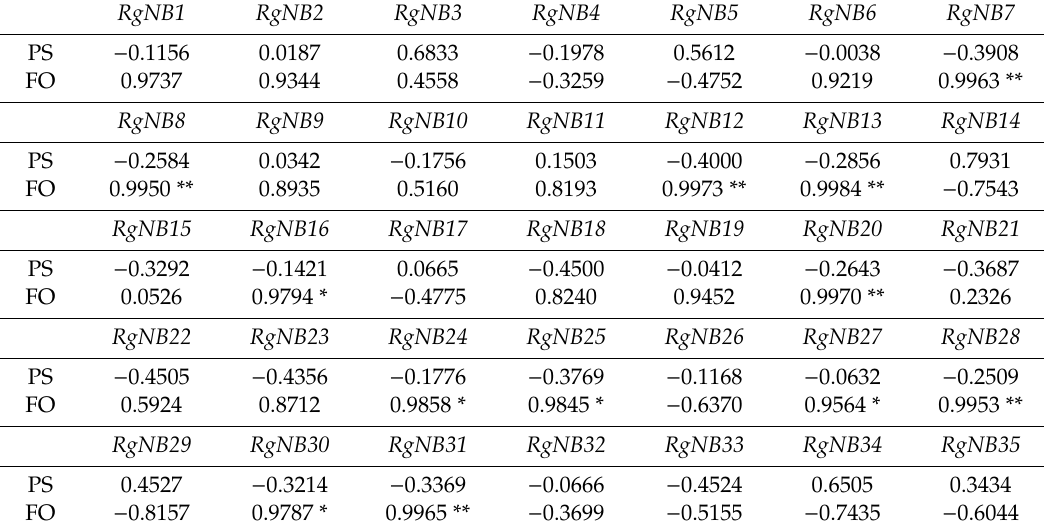
Table 3. Pearson correlations among the expression of 35 NB-LRRs and the variation of PS and FO numbers from 0 DAP to 3